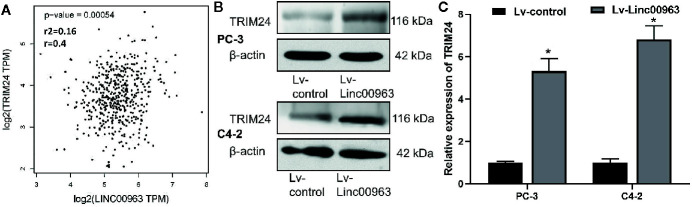
TRIM24 is positive correlated with Linc00963 in castration-resistant prostate cancer (CRPC) tissues and cells. (A) Correlation of Linc00963 and TRIM24 expression in 492 prostate adenocarcinoma (PRAD) patients from The Cancer Genome Atlas (TCGA) database, which was analyzed by using the Gene Expression Profiling Interactive Analysis website (http://gepia.cancer-pku.cn/); (B) The effects of Linc00963 on TRIM24 protein levels in CRPC cells; (C) The effects of Linc00963 on TRIM24 mRNA levels in CRPC cells; Data are shown as the mean ± S.E. *P < 0.05. The representative results of 3 independent experiments are shown.